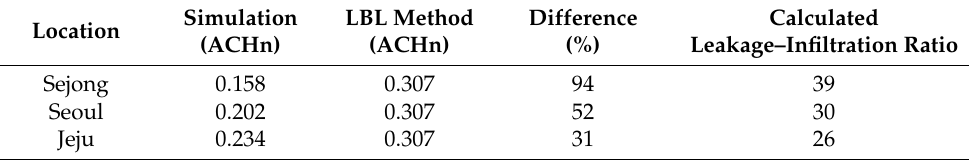
Table 3. Variation of the infiltration rate and leakage–infiltration ratio with the locations. Location